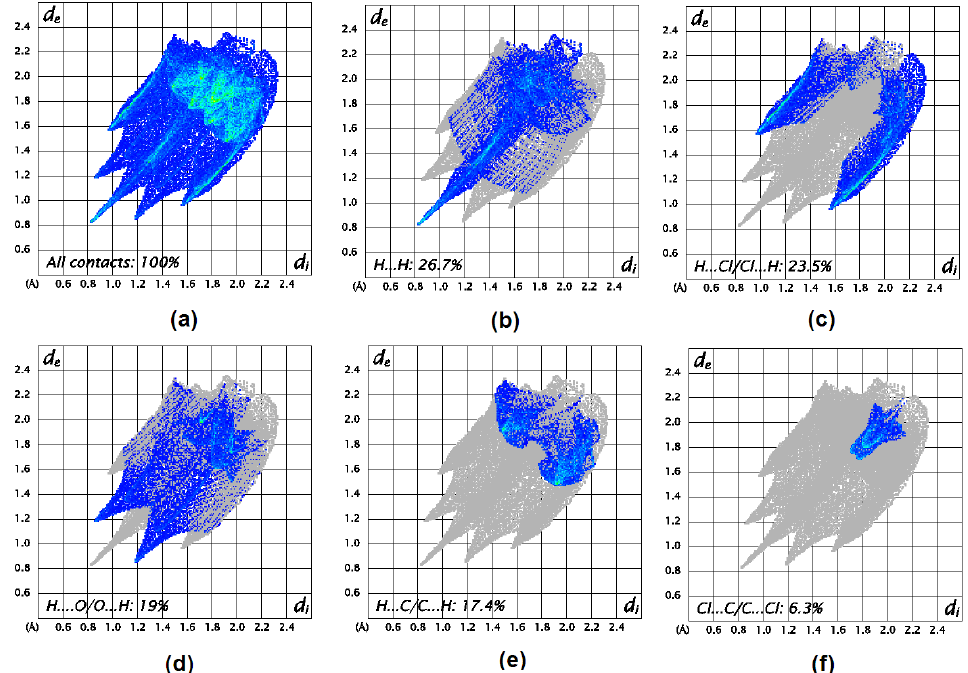
Figure 6. The full two-dimensional fingerprint plots for the title compound, showing ( a ) all interactions, and delineated into ( b ) H···H, ( c ) H···Cl/Cl···H, ( d ) H···O/O···H, ( e ) H···C/C···H and ( f ) Cl···C/C···Cl. The d i and d e values are the closest internal and external distances (in Å ) from given points on the Hirshfeld surface.